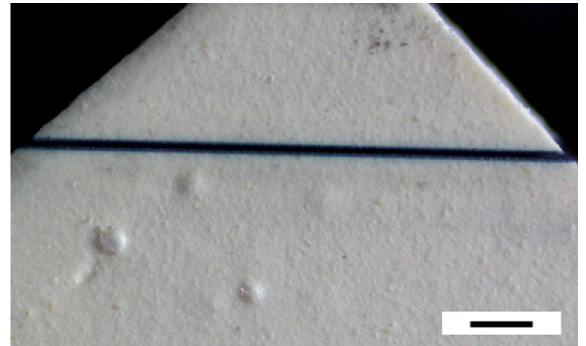
Figure A1. Optical image of a trench created with the femtosecond laser on a segment of alkyd paint sample 6 . The applied alkyd paint was produced by Winsor & Newton Griffin. The 220- μ m paint was casted on a 90- μ m polyester film in 2006. The total thickness of the paint was ~310 μ m. The black scale bar is 200 μ m. The 800-nm femtosecond laser cutting was performed at 2 mW with the XY translational speed of 1 mm/s.